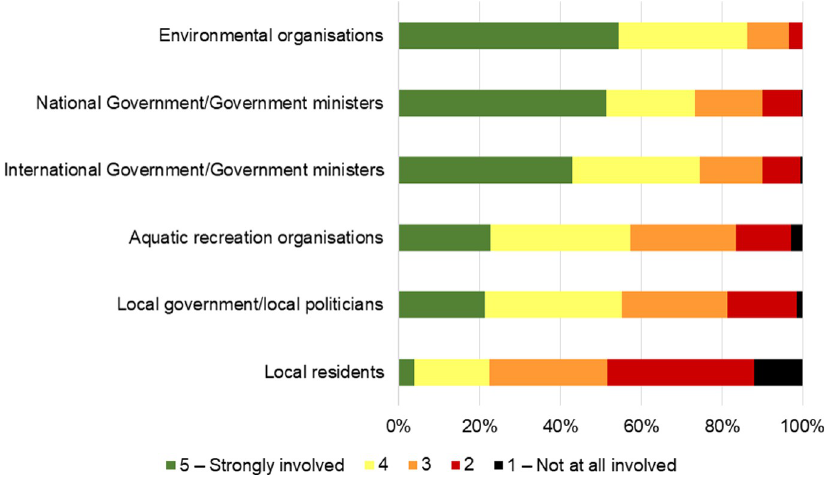
Fig 3. Empowerment in marine decision-making. Responses given by active marine citizens to the question "To what extent do you think each of the following are involved in marine and coastal decision-making?”. Chart shows Likert score for each category on a 5-point scale from not at all involved (1) to strongly involved (5). N =